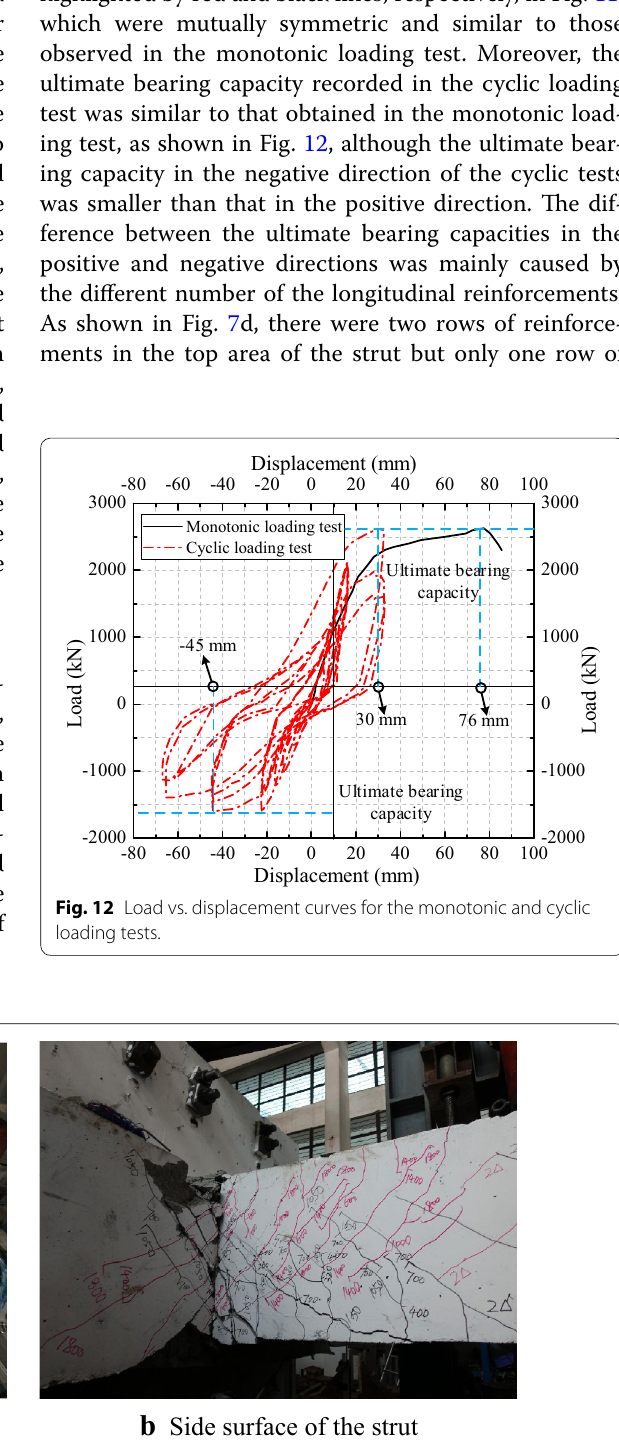
Fig. 11 Ultimate failure of the specimen.